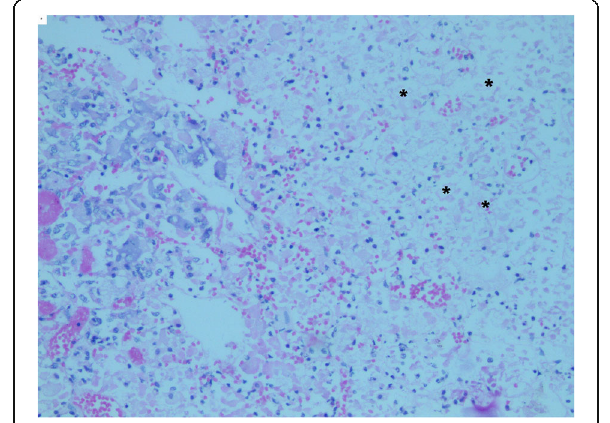
Fig. 5 Section from adrenal gland asterisk area shows coagulative necrosis/infarction, H&E stain, × 200